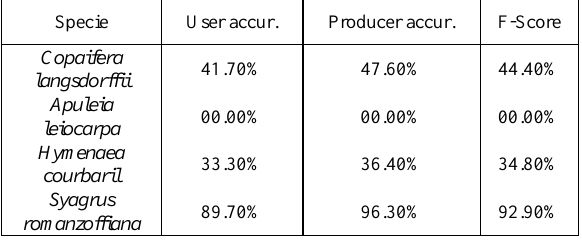
Table 6. Result of the 10-fold cross validation model of the RF in the region-based approach classification